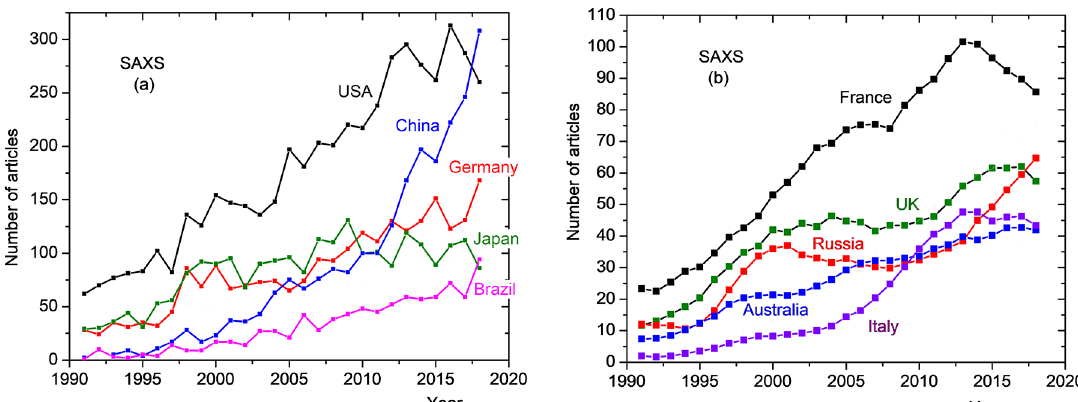
Figure 3. Historical evolution of the annual number of articles related to SAXS corresponding to the ten most productive countries in 2018. (a) Countries for which the number of articles published in 2018 range from ~ 80 up to 310. (b) Countries for which the number of articles published in 2018 range from ~ 50 up to 80. Data in (b) were smoothed by five adjacent point